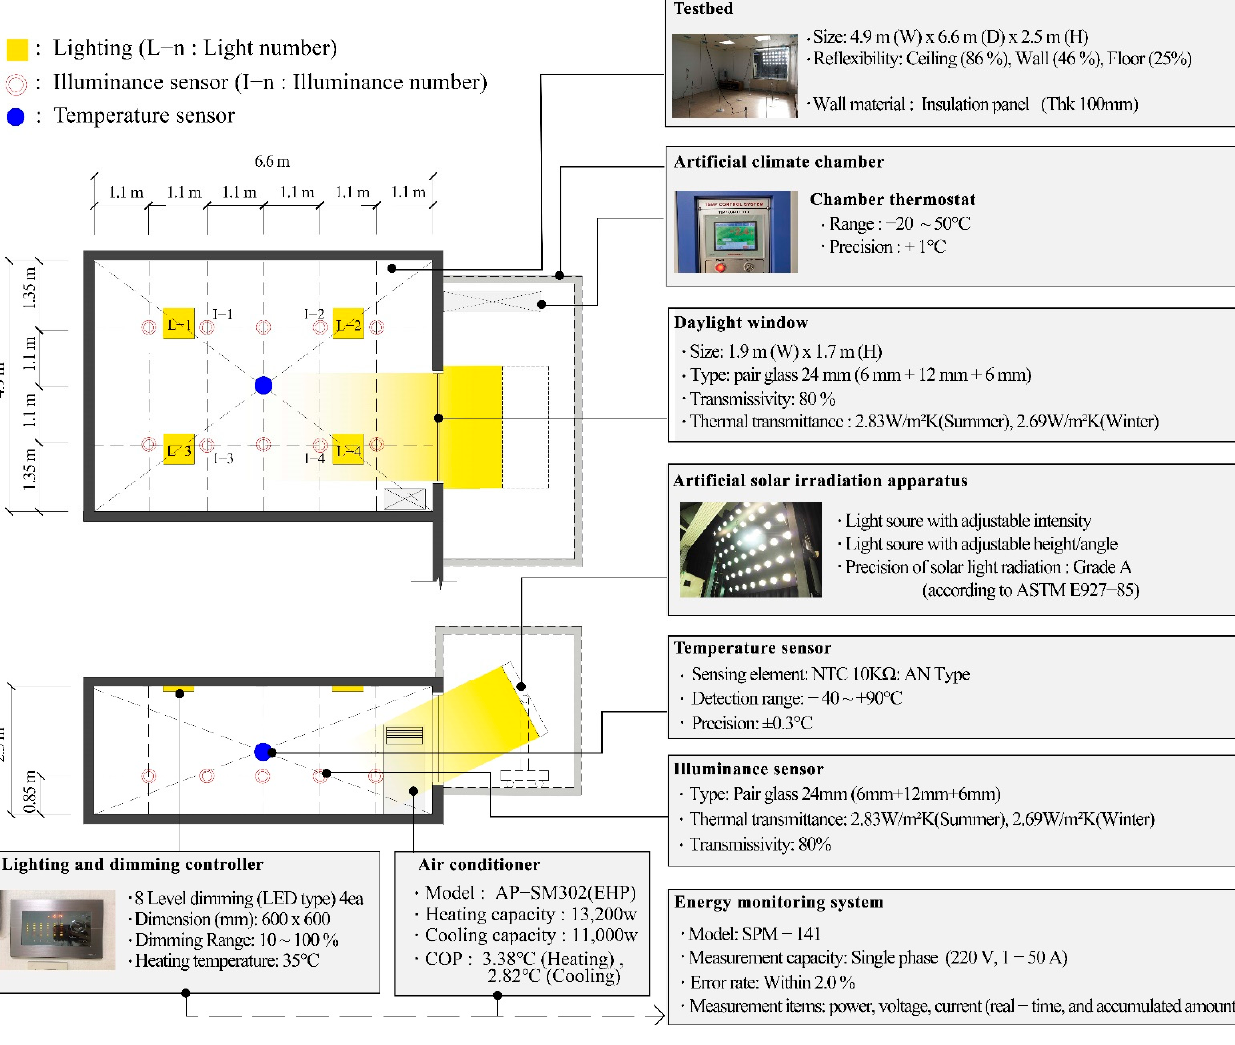
( d ) Figure 6. Test specimens for performance evaluation: ( a ) fabrication of moving parts (profile), ( b ) awing installation, ( c ) awning control, and ( d ) installation in the test bed. Second, as shown in Table 3, five cases were configured to validate the effectiveness of the proposed STML system (Case 5). Case 1 was set as a daylighting window without a louver installed. Case 2 was a vertical louver with seven slats, and the width, depth, and height of each slat were set to 0.03, 0.25, and 1.65 m, respectively, based on a related study [28]. The interval between each slat was 0.29 m. Case 3 was a horizontal louver with six slats. Case 4 was an eggcrate louver with a structure that combined Cases 1 and 2. As shown in Figure 7, the slats in Cases 2 and 3 could be controlled to different angles (90°, − 45°, 0°, 45°) relative to the daylighting window. In Case 4, the slats were fi xed at an angle perpendicular to the window. The slats in Cases 1, 2, 3, and 4 were made of aluminum with 70% reflectance. Furthermore, the louver arms in Case 5 could be controlled in eight steps, ranging from a minimum of 0.2 m to a maximum of 1.6 m, as shown in Figure 8.